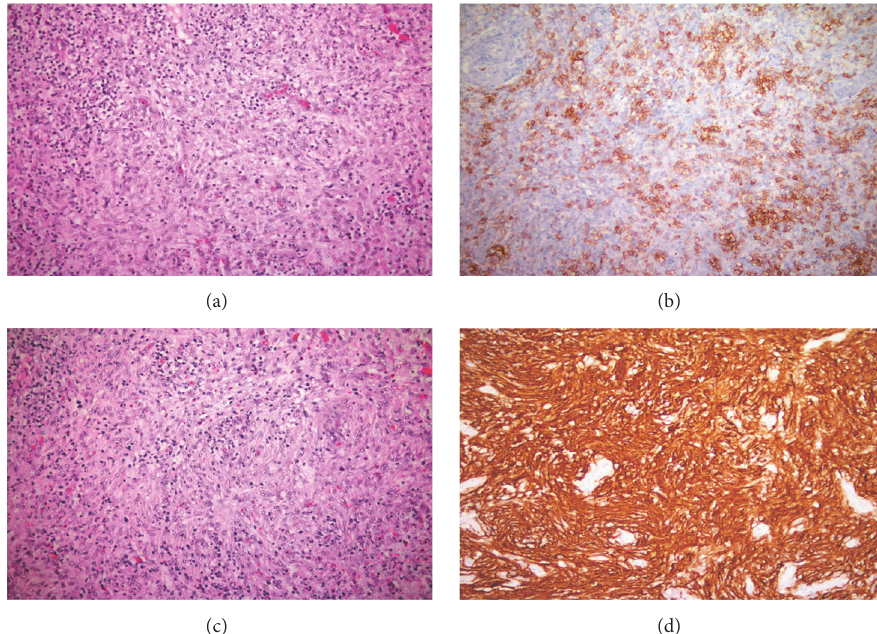
Figure 1: (a) Both components of the histologic picture are seen in this section. Small-to-medium-sized lymphoid cells with clear cytoplasm and eosinophils are segregated by intervening whorls of spindly follicular dendritic cells (H&E × 320). (b) Numerous PD1+ cells are found in the cellular area of the lesion consistent with AITL (Immunohistochemistry with DAB × 320). (c) Several whorls of follicular dendritic cells are prominent in this section (H&E × 320). (d) The spindle follicular dendritic cells show very strong CD21 immunostaining. Note the negative staining related to the high endothelial venules (Immunohistochemistry with DAB ×